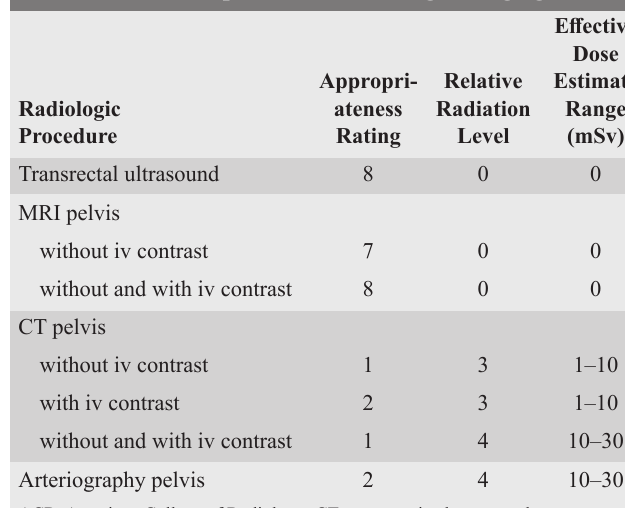
Table 4. ACR Appropriateness Criteria ® on Hematospermia; Patients Over 40 Years of Age, or Any Age with Recurrent Hematospermia, or Hematospermia Accompanied by Associated Symptoms or Signs of Disease (Modified From Expert Panel on Urologic Imaging, 2017).